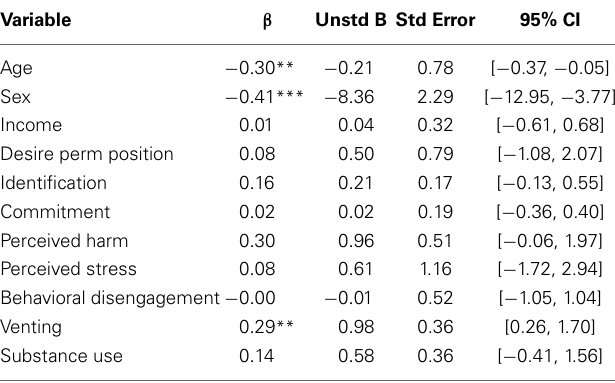
Table 11 | Standard multiple regression predicting